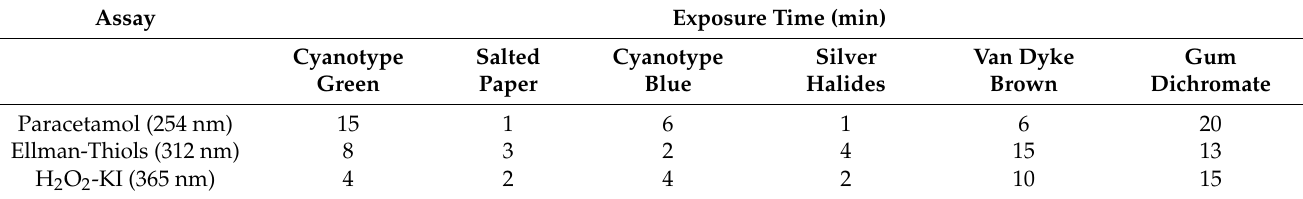
Table 1. Optimum irradiation time for various assays and photosensitive paper coatings.